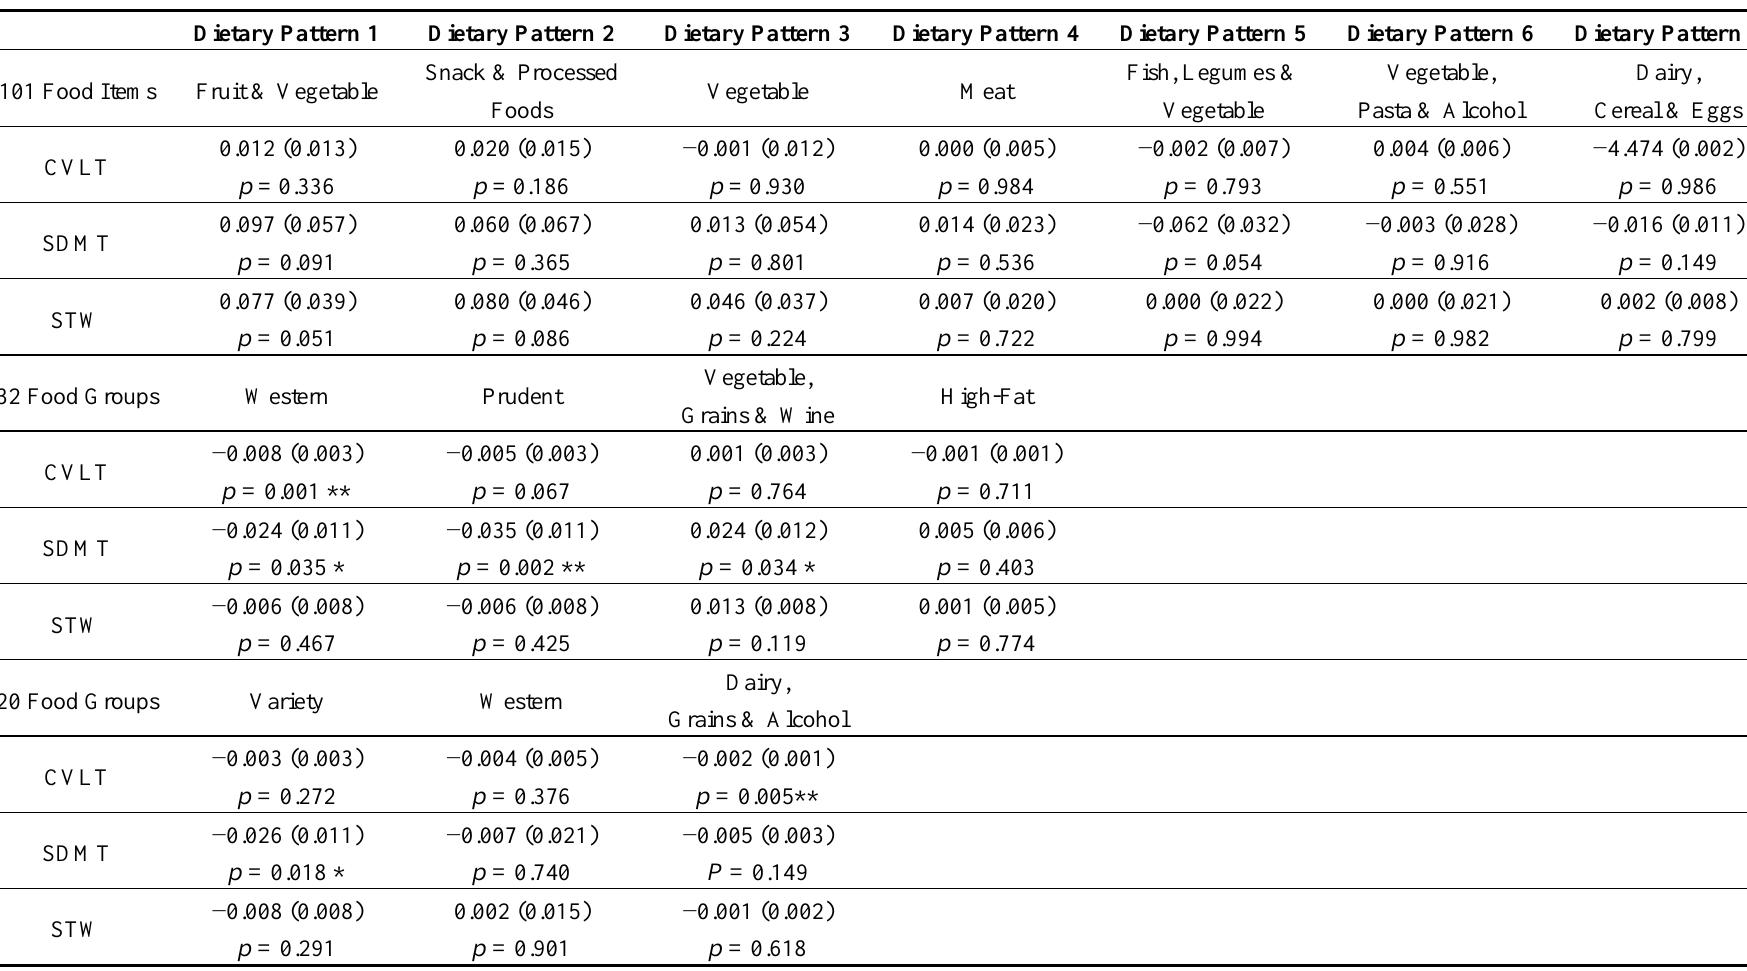
Table 4. Results of GLM showing associations between cognitive function at Wave 3 and dietary patterns obtained using 101 individual food items, 32 food groups and 20 food groups at Waves 1, 2 and 3